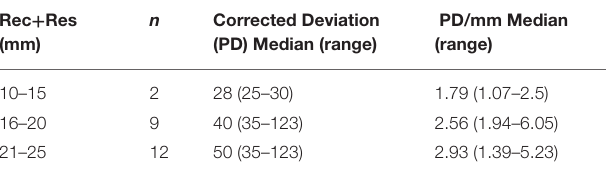
TABLE 5 | The dose-effect of maximal R-R